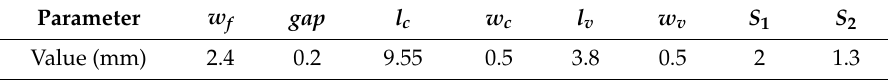
Table 2. Possible states for single resonator.